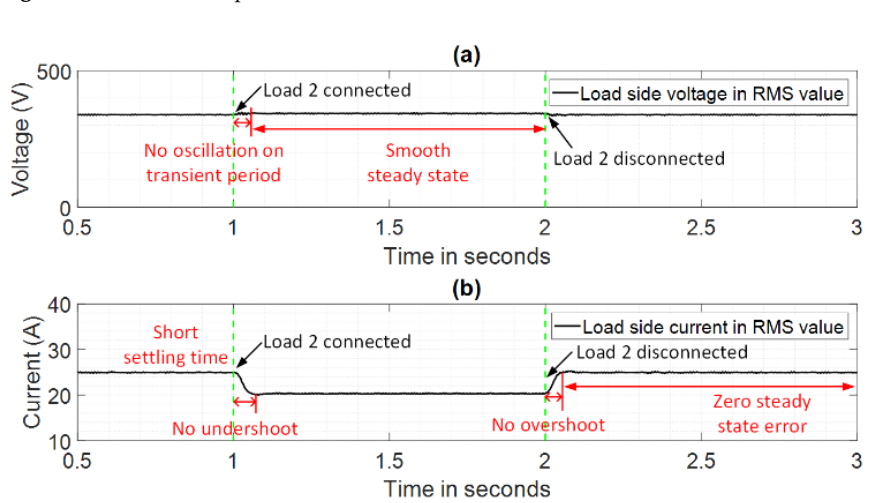
Figure 10. Pole zero map.